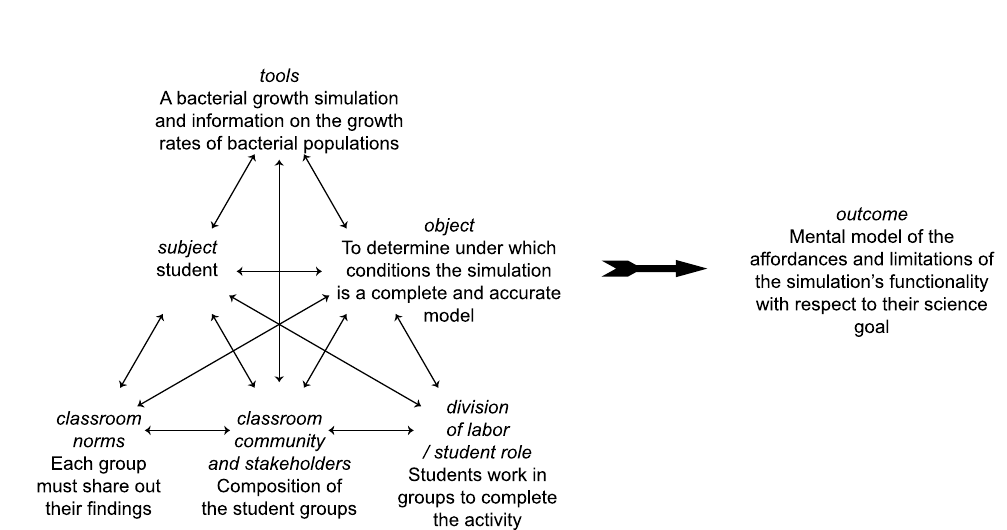
Fig. 6 Evaluation of a computational tool for modeling activity